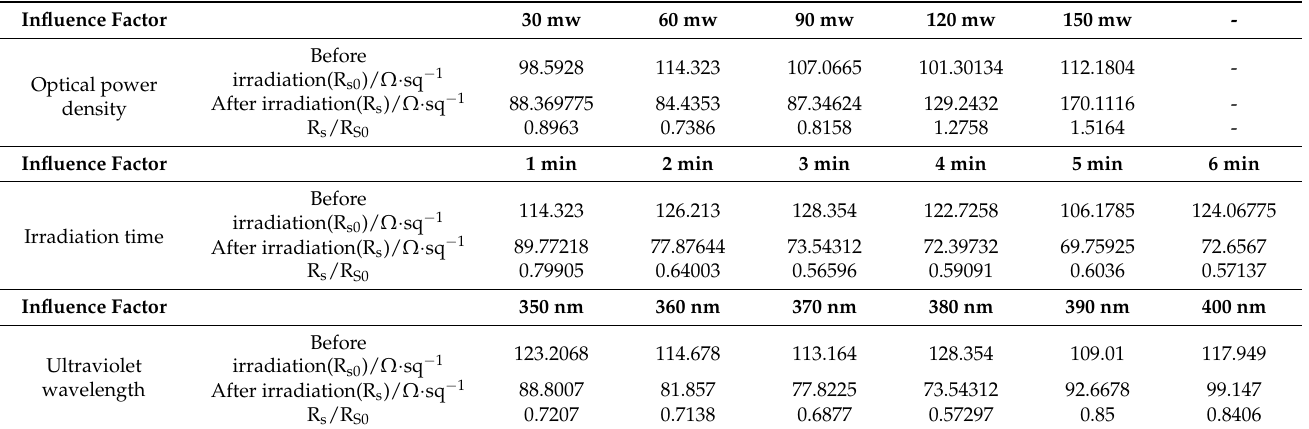
Table 1. Variation of sheet resistance of AgNWs under ultraviolet irradiation under different influ- encing factors.